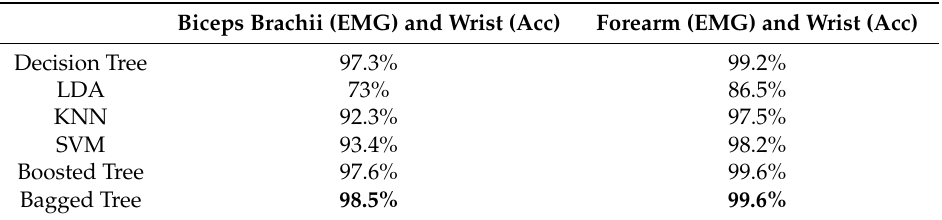
Table 4. Classification accuracies based on